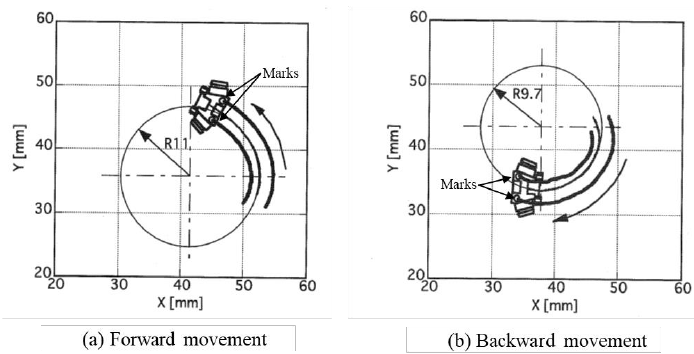
Figure 19. Turning trajectories. ( a ) The trajectories of forward movement. ( b ) The trajectories of backward movement. The three trajectories are those of the two target marks and the center of the microrobot. The circle drawn by a thin line is a circle of the minimum turning radius obtained from the trajectory.